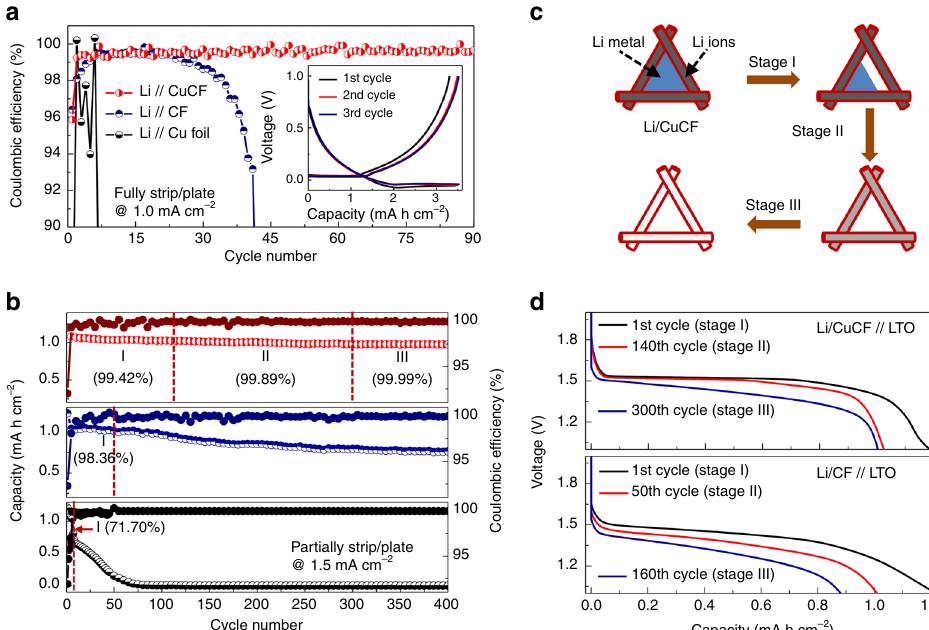
Fig. 3 Cycling stability and storage mechanism of lithium anode. a The Coulombic ef fi ciency (CE) of various Li anodes including lithiated copper-deposited carbon fabric (Li/CuCF), lithiated carbon fabric (Li/CF) and lithiated copper foil (Li/Cu foil) during cycling against Li foil, where 3.5 mA h cm − 2 of Li is fully plated and stripped at 1 mA cm − 2 . The pro fi les of areal capacity versus voltage for Li/CuCF anode are recorded in the inset. b Areal capacities and corresponding CE values of Li/CuCF, Li/CF, and Li/Cu foil anode- Li 4 Ti 5 O 12 (LTO) cells for 400 cycles are plotted at a current density of 1.5 mA cm − 2 from top to bottom, respectively. The cycling process is involved in three stages: Stage I represents the cycling process that only occurs to the plated Li metal; Stage II represents the cycling process that occurs to both the plated Li metal and the inserted Li + ; Stage III represents the cycling process that only occurs to the inserted Li + . c Scheme of three cycling Stages (I, II, and III) for Li/CuCF anode. d Galvanostatic discharge pro fi les of Li/CuCF-LTO and Li/CF-LTO cells at 1.5 mA cm − 2 for various cycling stages. The areal capacity of Li metal anodes is 3.5 mA h cm − 2 in all